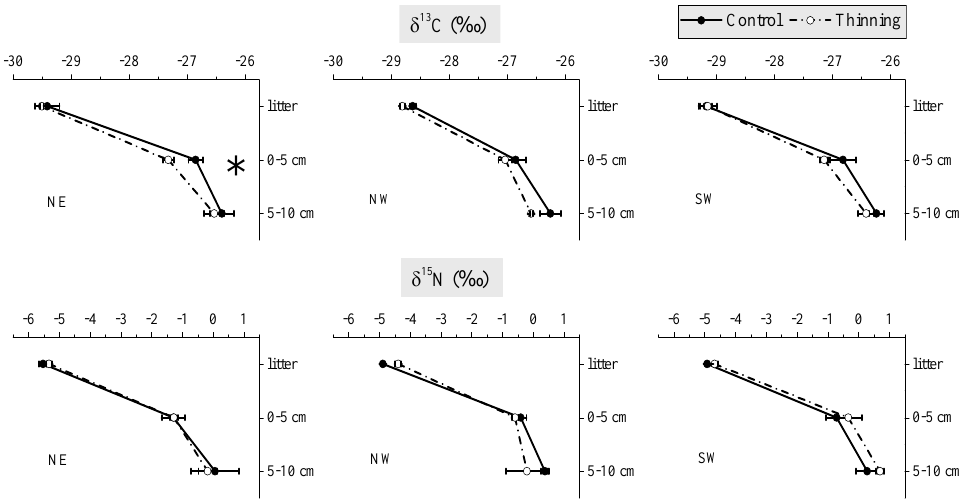
Figure 3. δ 13 C (upper panels) and δ 15 N (lower panels) in soil and leaf litter. Black line: control; dotted line: thinning. Asterisks indicate significant differences between control and thinned plots at a given depth.